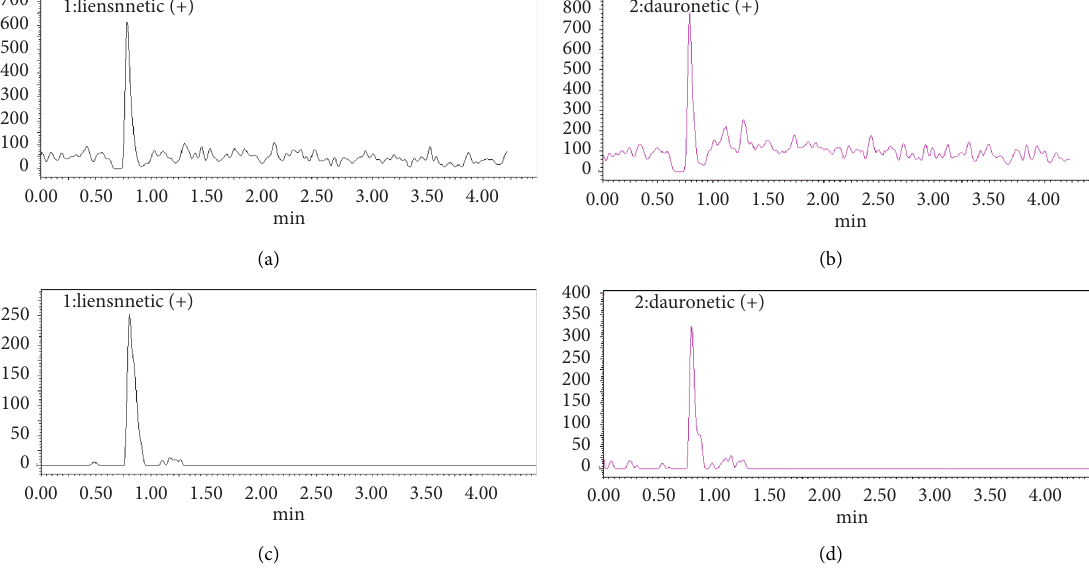
Figure 3: Chromatogram of (a) liensinine 10 ng/mL and (b) dauricine 20 ng/mL on a Sunfire-C18 column. (c) Liensinine 10 ng/mL and (d) dauricine 20 ng/mL on a Gemini-C18 column at low pH conditions (0.1% formic acid pH